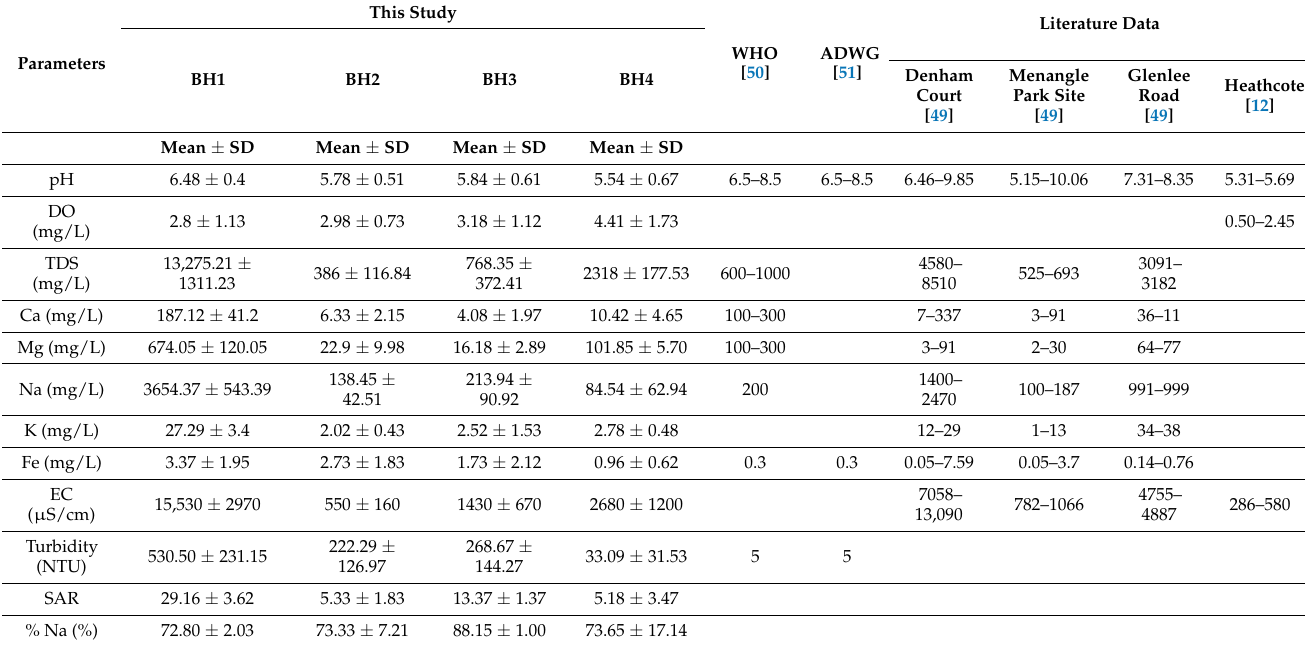
Table 4. Groundwater quality results from this study and local study from the same